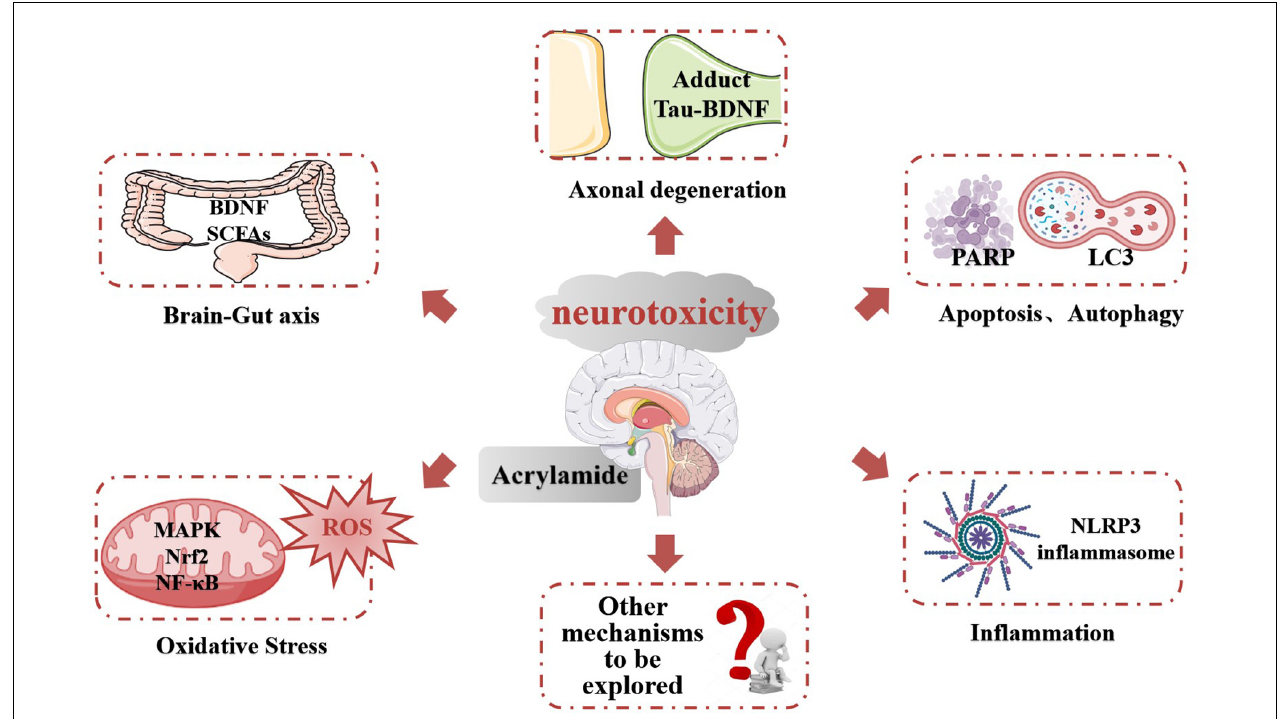
FIGURE 3 | The potential mechanism of ACR-induced